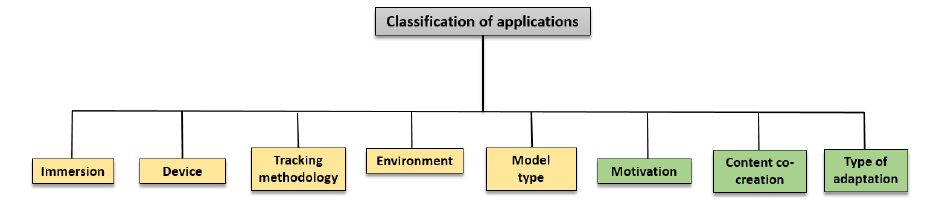
Figure 3. Classification of applications.